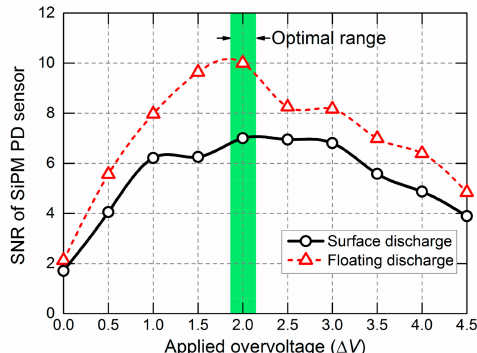
Figure 1. SNR of SiPM PD detection vs. applied over-voltage. The operating ambient temperature is approximately 25 ◦ C. Surface discharge and floating discharge in an atmosphere of air are employed as PD light sources. The distance between the sensor and the PD source is 270 mm.